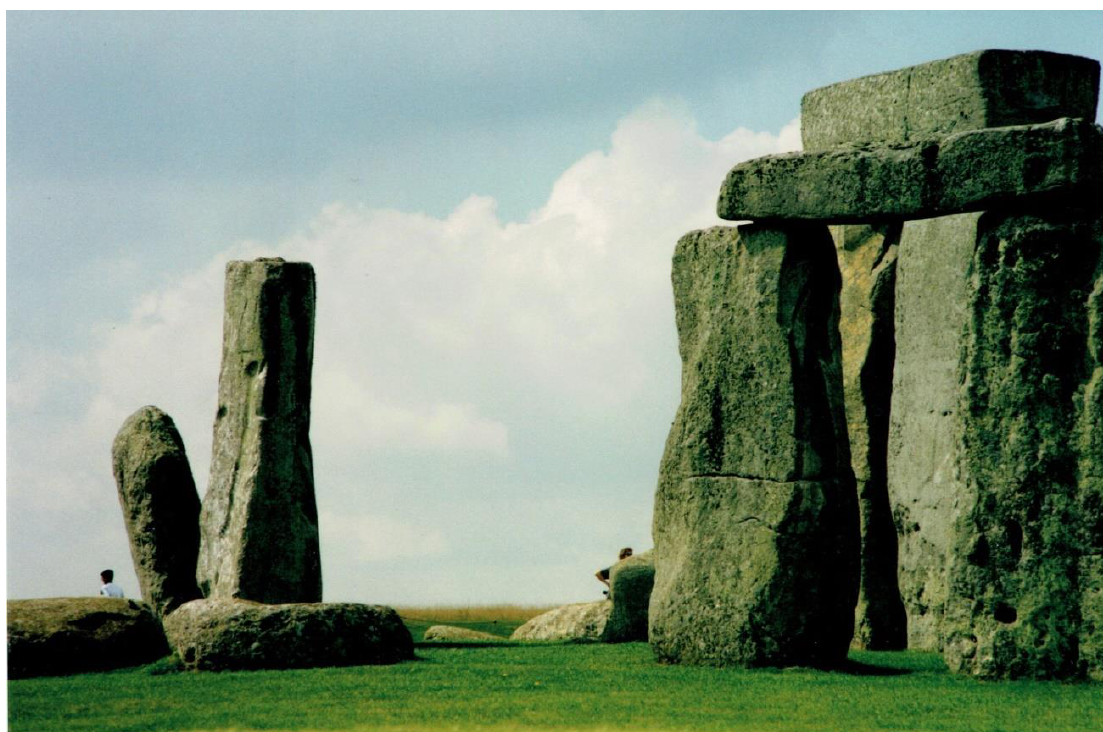
Figure 10. The enigmatic Stone 11 (leaning, at left of the picture) stands next to Stone 10 which is a normal stone of the outer sarsen circle. This emphasizes its anomalous shortness and rounded top. The nearest orthostats at the right are Stones 6 and 7. Lying battered and broken on the ground between standing Stones 7 and 10 are sarsen Stones 8 and 9 having fallen outwards. (Photograph by the author, 25 August 1997)